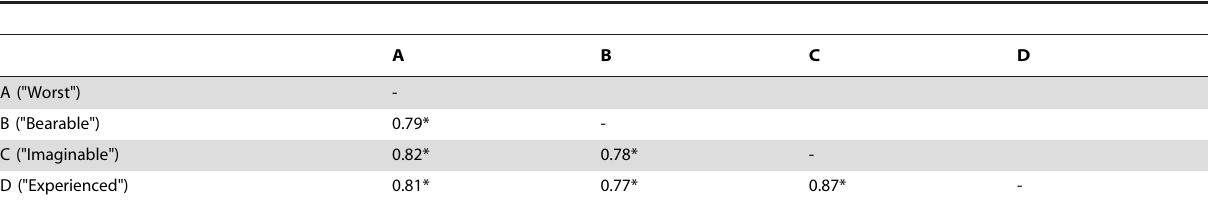
Table 3. Pairwise Spearman’s rank correlation coefficient between the pain intensity measured by VASs using four anchor descriptors.